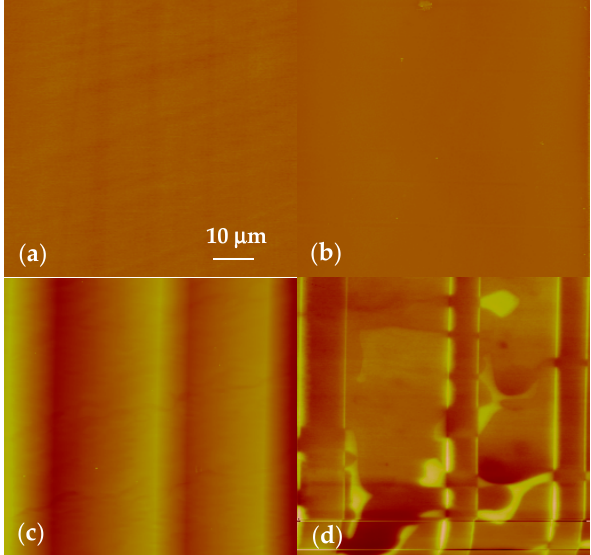
Figure 1. Phase transitions from cubic (135 °C) to tetragonal (90 °C). AFM topography ( a ) and surface potential map ( b ) of the (001) BaTiO 3 surface acquiring at 135 °C which is above the Curie temperature of BaTiO 3 at 120 °C with a 40 nm Z scale and the roughness was 0.68 nm. AFM topography image with a 200 nm Z scale ( c ) and surface potential mapping with a 0.6 V Z scale ( d ) acquired after cooling to 90 °C showing typical a-c domain structures.